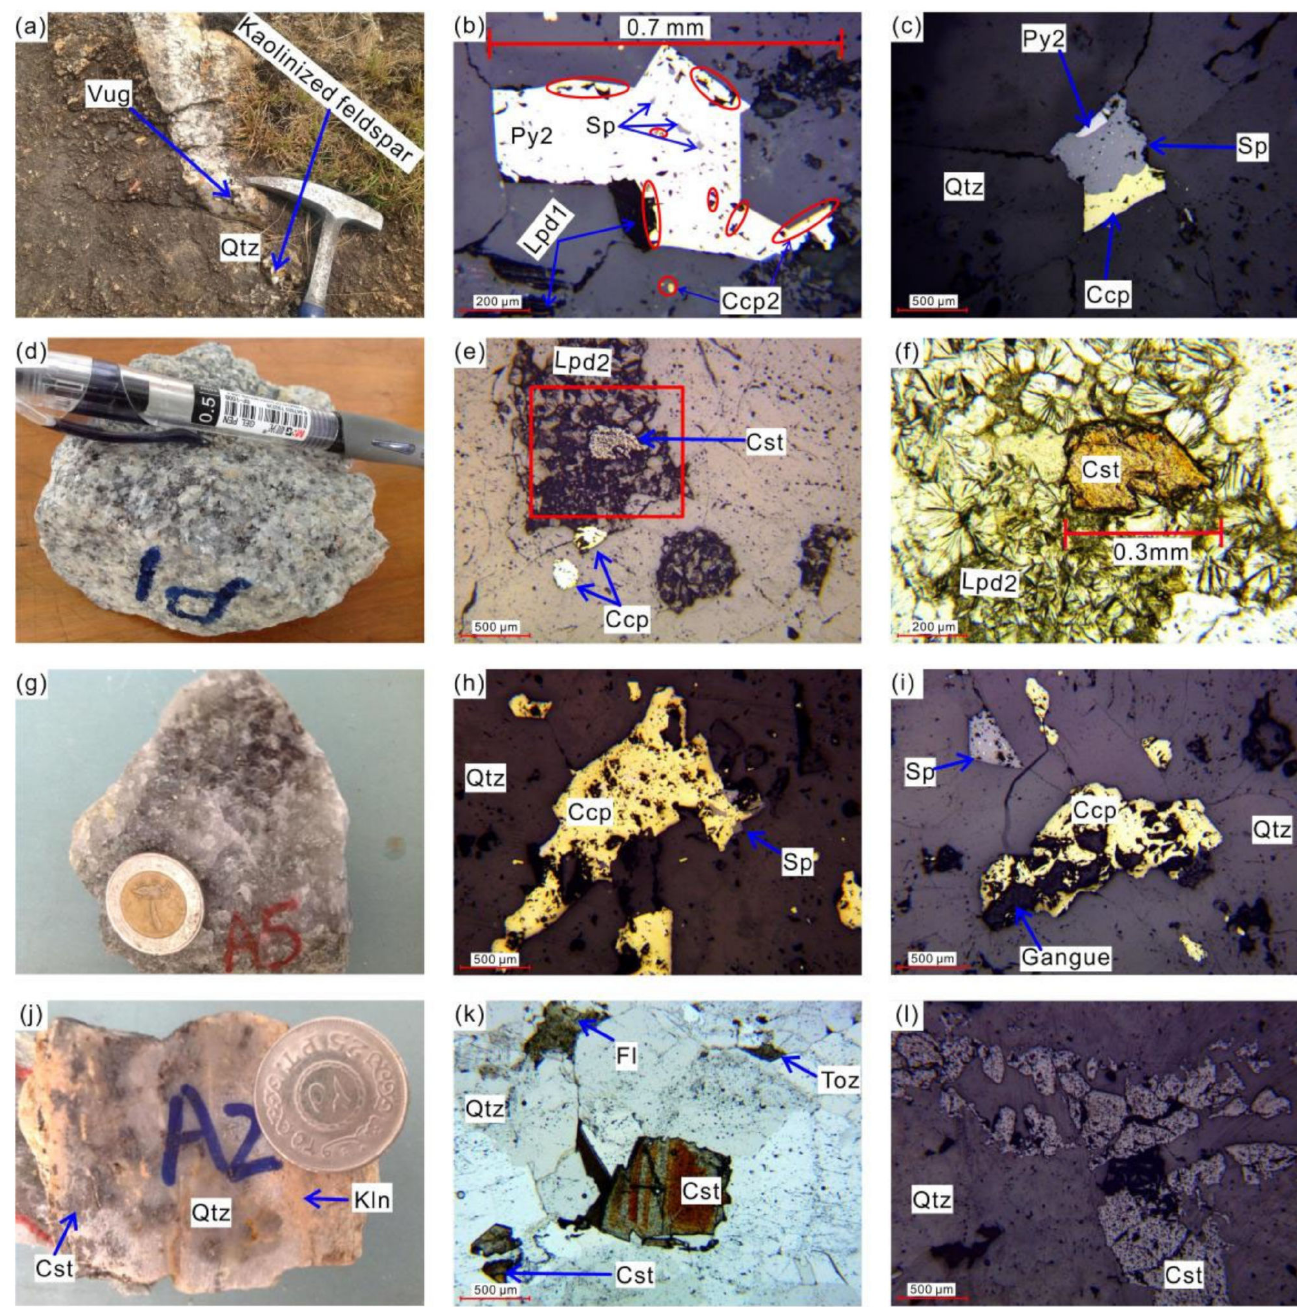
Figure 6. Field photograph, hand specimens, and microphotographs of mineralized rocks from the Gindi Akwati deposit. ( a ) quartz vein with vugs and kaolinized feldspar in greisenized granite; ( b ) typical oxidation halos around lepidolite; ( c ) euhedral granular sulfides co-precipitated; ( d , e ) greis- enized granite containing co-existing cassiterite and chalcopyrite; ( f ) magnified view showing comb textured lepidolite; ( g ) contact between the ore-bearing vein and greisenized granite; ( h , i ) chal- copyrite with sphalerite rim, fine corrosive inclusions and chalcopyrite cut by replacive gangue; ( j – l ) pseudo-alignment of cassiterite grains, alteration of feldspar to kaolin and accessory fluorite and topaz. Ccp = chalcopyrite, Cst = cassiterite, Fl = fluorite, Kln = kaolinite, Lpd = lepidolite, Py = pyrite, Qtz = quartz, Sp = sphalerite, Toz =